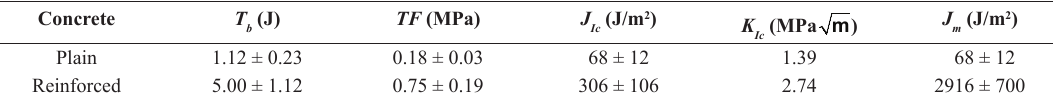
Figure 4. Typical load deflection curves obtained in four point bending of unnotched beams for plain concrete (a) and fiber reinforced concrete (b). Table 3. Toughness parameters as determined for the concretes in